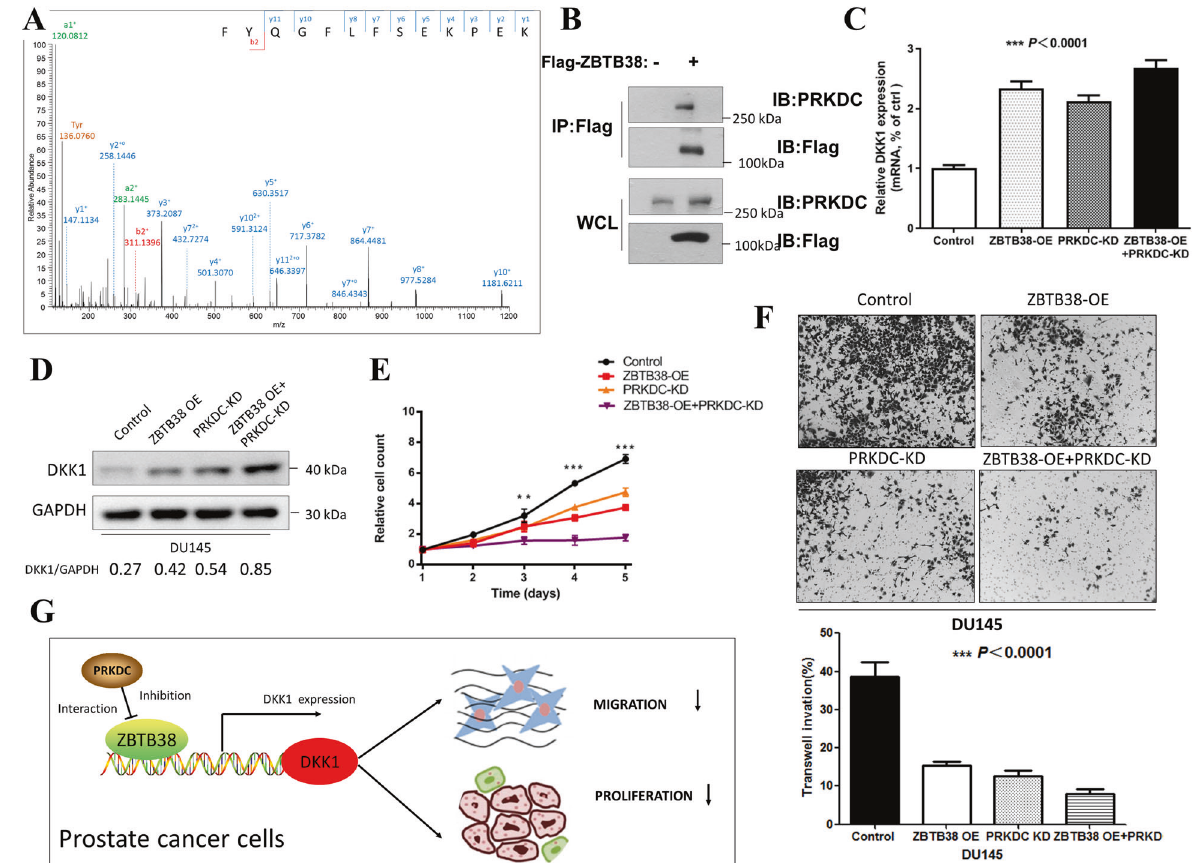
Fig. 5 PRKDC interacts with ZBTB38 and inhibits the function of ZBTB38 . A Mass spectrometry identi fi cation of a higher-energy collisional dissociation (HCD) MS/MS spectrum was recorded on the [M + 3H]3 + ion at m/z 540.94 of the human prKDC peptide FYQGFLFSEKPEK. Predicted a-, b-, and y-type ions (not including all) are listed above and below the peptide sequence, respectively. The cycle symbol means the neutral loss of water. B Co-IP analysis of the interaction between ZBTB38 and PRKDC . C PRKDC knockdown induced DKK1 upregulation in mRNA expression level. One-way ANOVA analysis was used. D PRKDC knockdown induced upregulation of DKK1 protein. E PRKDC knockdown reduced ZBTB38 -mediated proliferation in DU145 cells (** P < 0.01, *** P < 0.001). F PRKDC knockdown reduced ZBTB38 -mediated migration